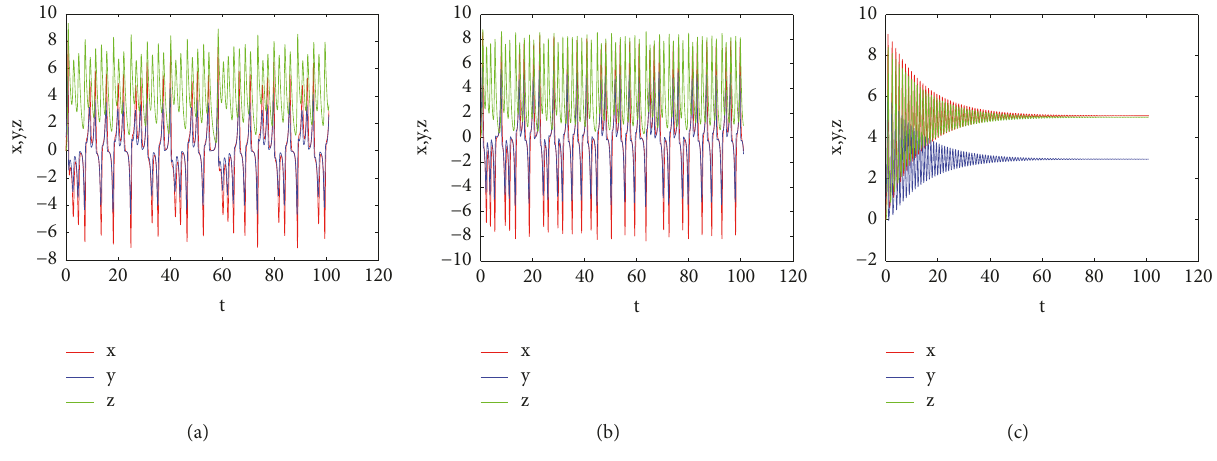
Figure 7: The time series plots of chaotic system for Experiment 2: (a) 𝑏 = 1 ; (b) 𝑏 = 2 ; (c) 𝑏 = 3